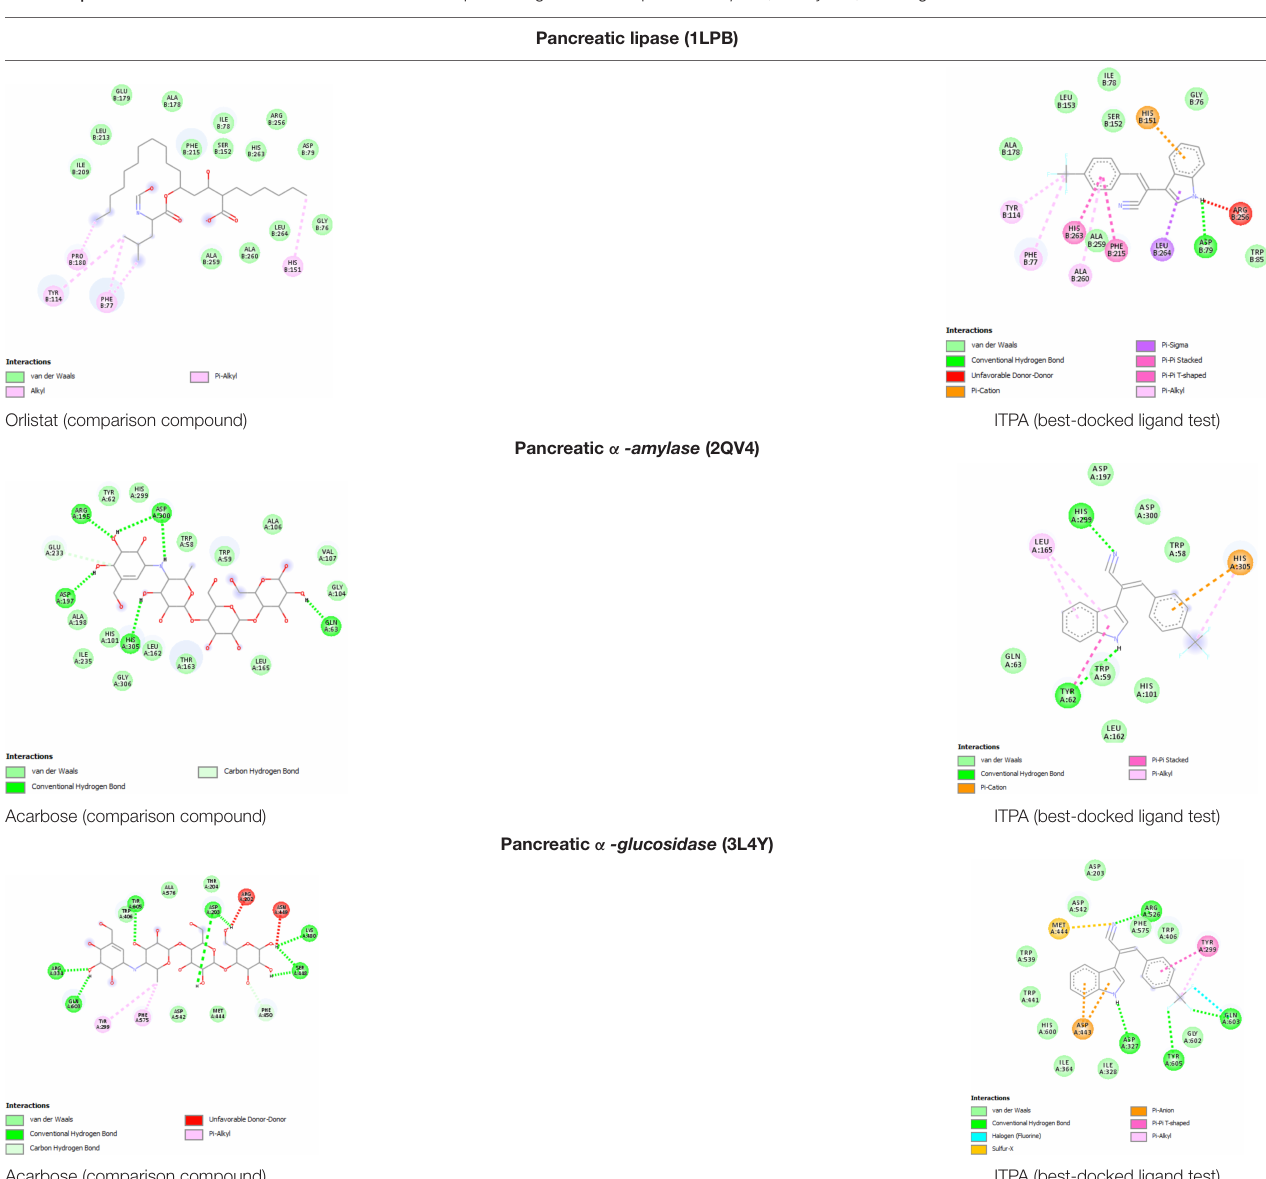
TABLE 4 | Amino acid interaction of C. racemosa active compounds against human pancreatic lipase , α -amylase , and α -glucosidase